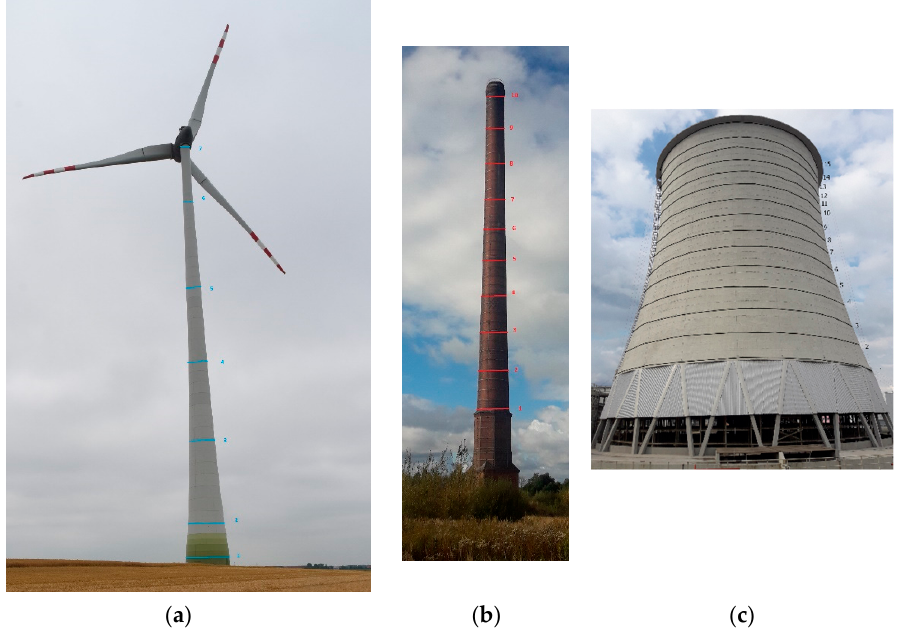
Figure 1. Photographs of ( a ) wind turbine tower, ( b ) smokestack, and ( c ) cooling tower with the measurement levels.